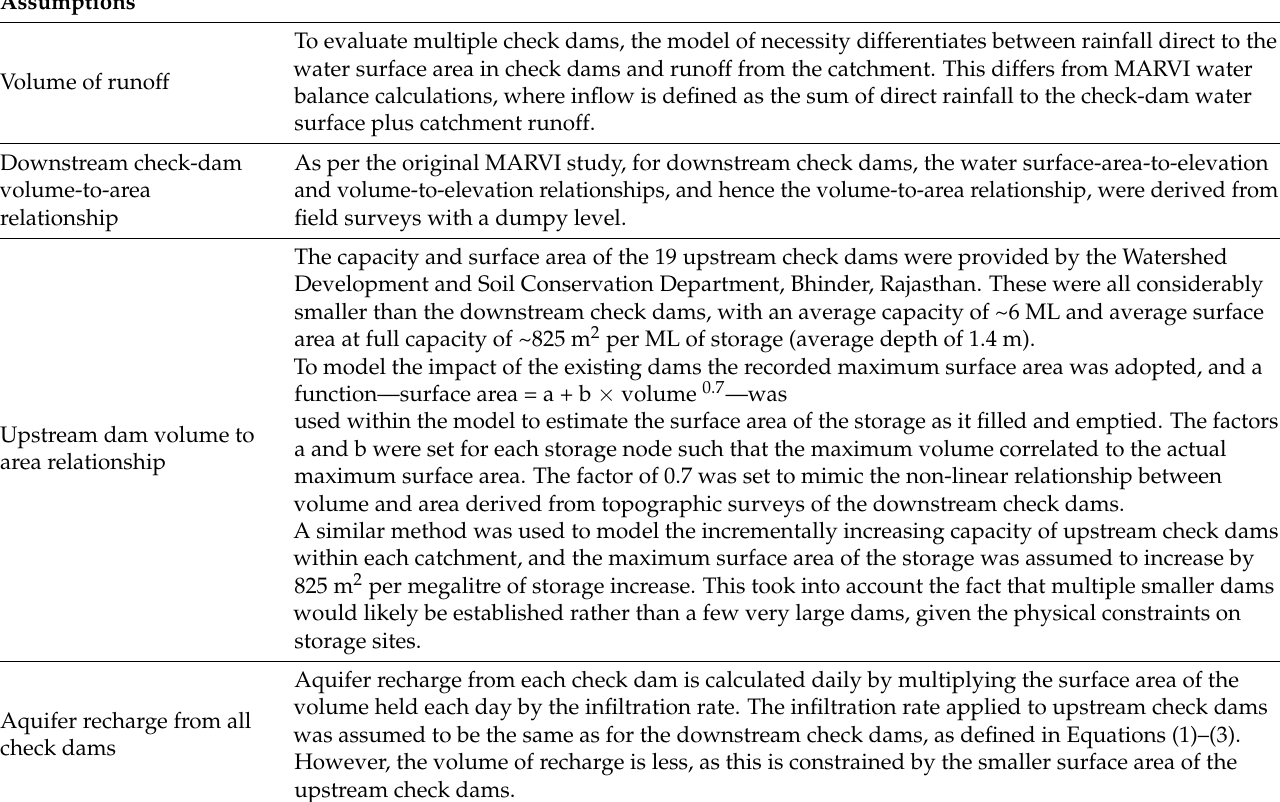
Table 2. Assumptions adopted in WaterCress to model runoff into and recharge from check